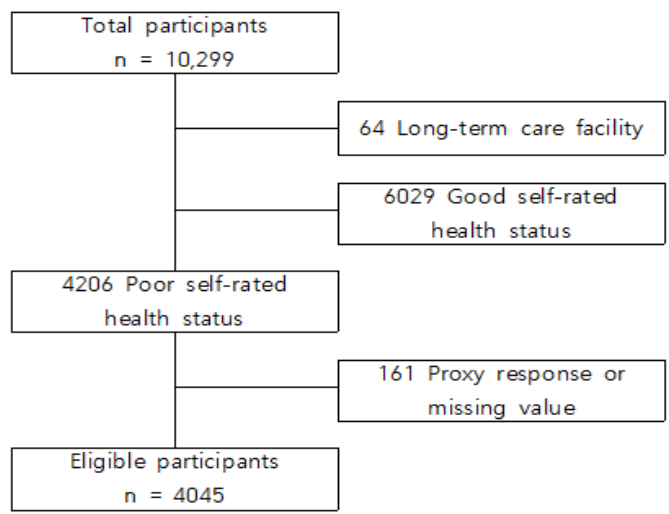
Figure 1. Consort flow diagram of study population inclusion.